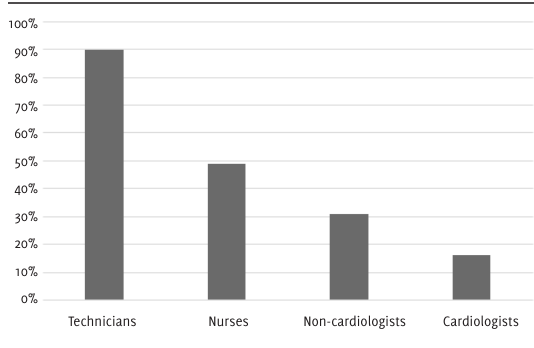
All limb electro- All limb electro- Combination of des on wrists and des on trunk trunk and limbs ankles Figure 2. Proportion of professionals who correctly positio- ned the V1 electrode (adapted from Rajaganeshan et al.). 14